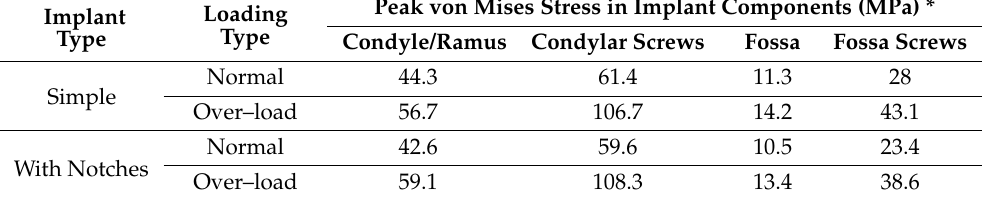
Table 4. Peak von Mises stresses developed in condyle/ramus and fossa components, and fixa- tion screws of the simple and notched designs of patient-specific total TMJ prostheses during FE simulations under normal and worst-case/over–loading configurations.